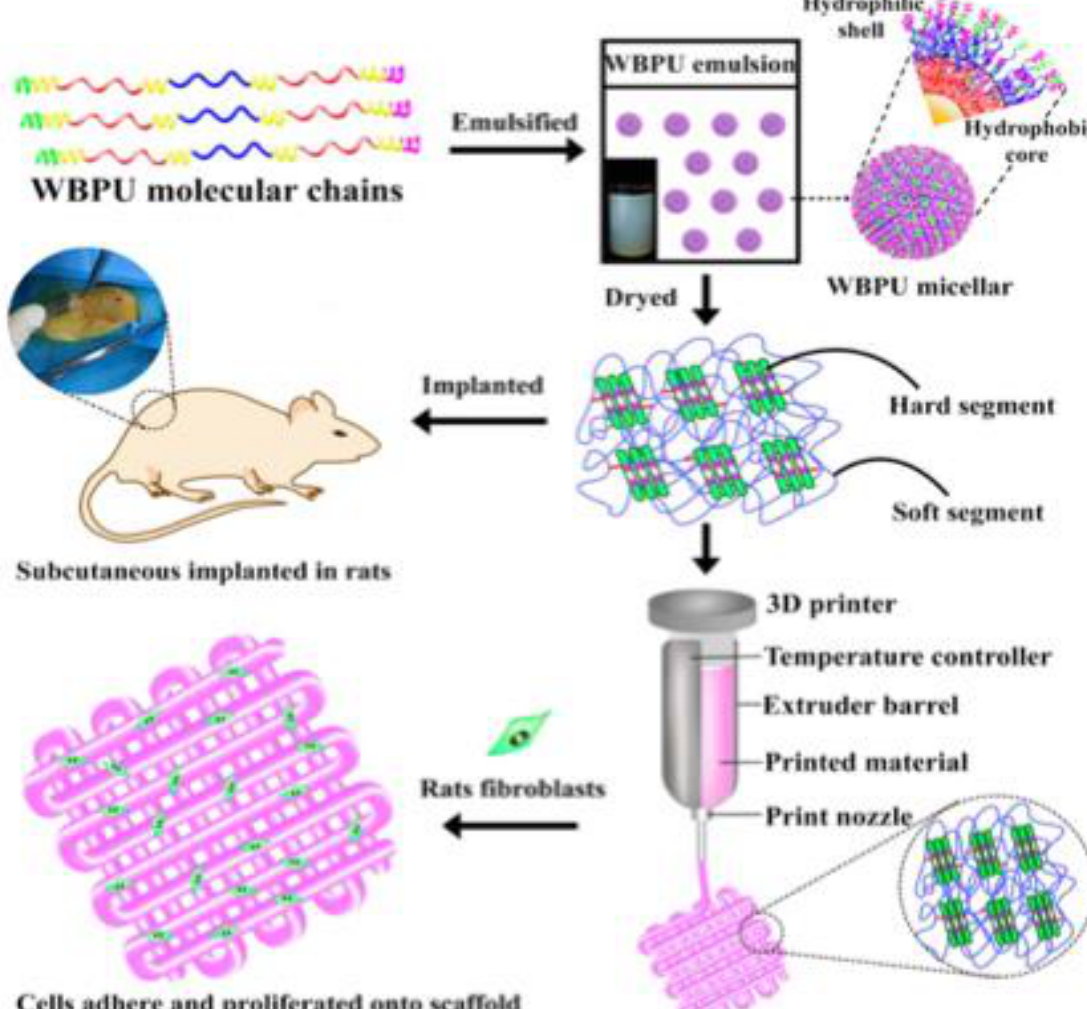
Figure 8. The self-assembled micellar structure of WBPU (PUDs) and the bioprinting process of WBPU by a self-developed platform (reproduced with permission from [86]).